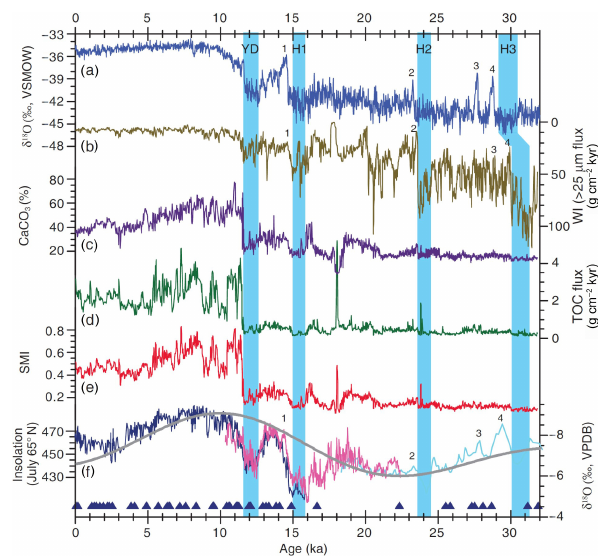
Figure 8. Proxy ISM records since 2.60Ma from the Heqing Basin, southwestern China (An et al., 2011).